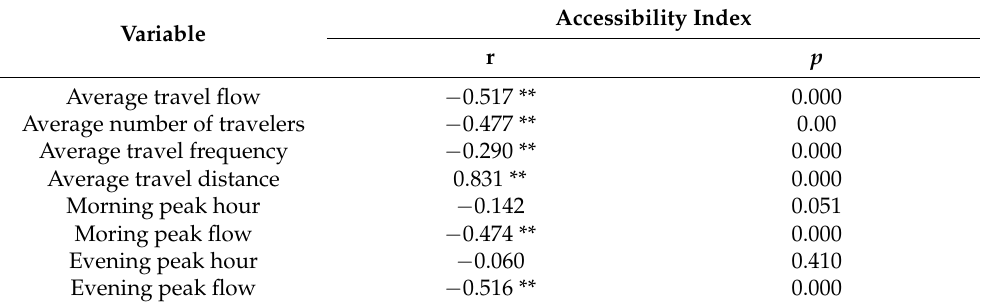
Table 10. Correlation analysis results of resident travel characteristics and accessibility index in